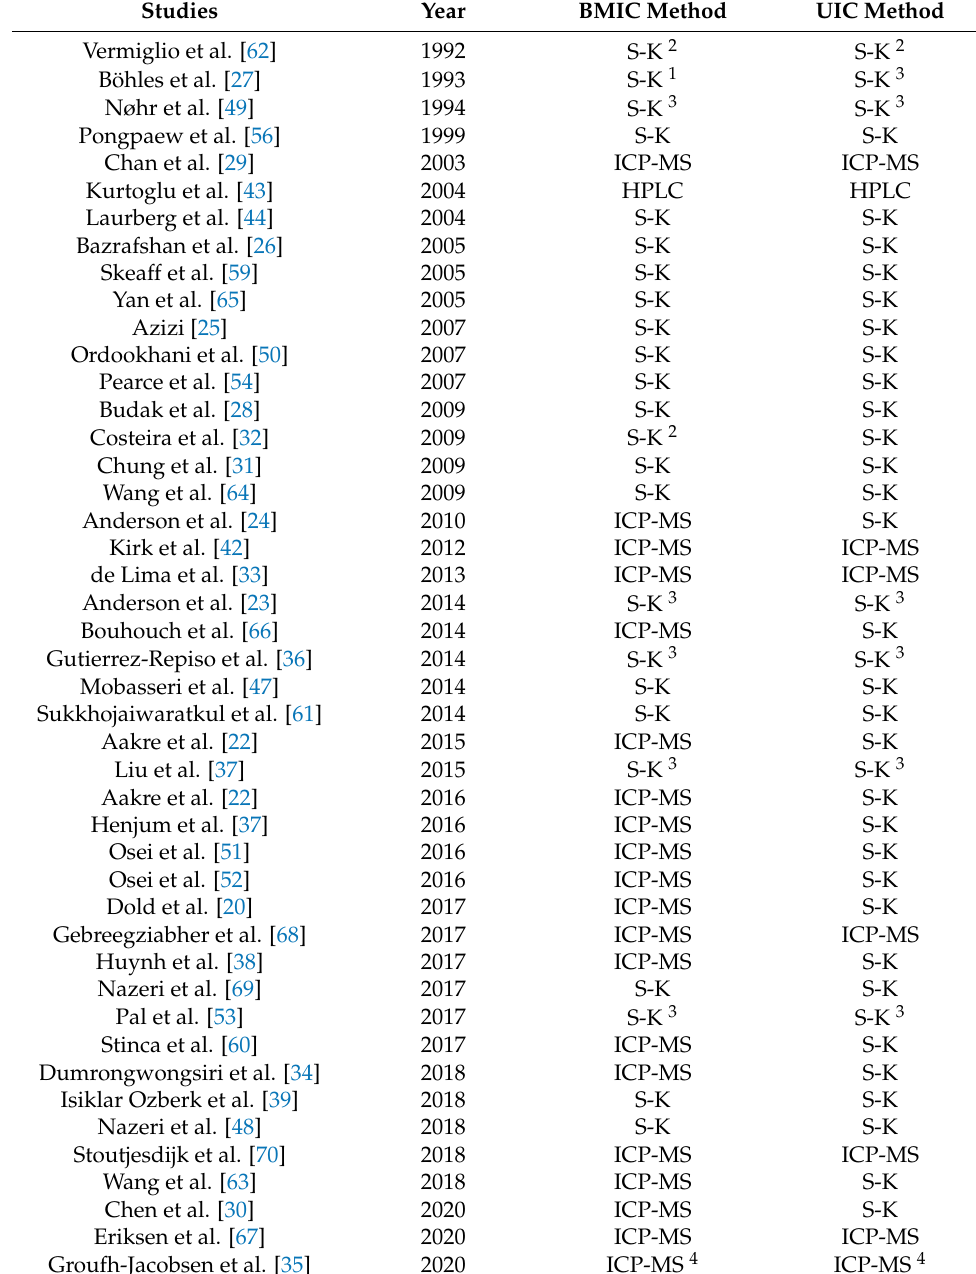
Table 2. Types of BMIC and UIC methods in studies assessing BMIC and UIC in lactating women and their